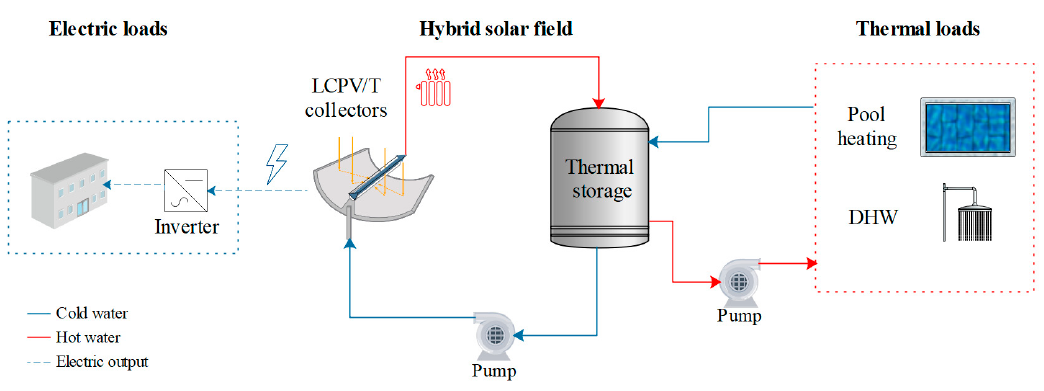
Figure 1. Configuration of the hybrid solar heat and power system (Source: Author’s own conception).